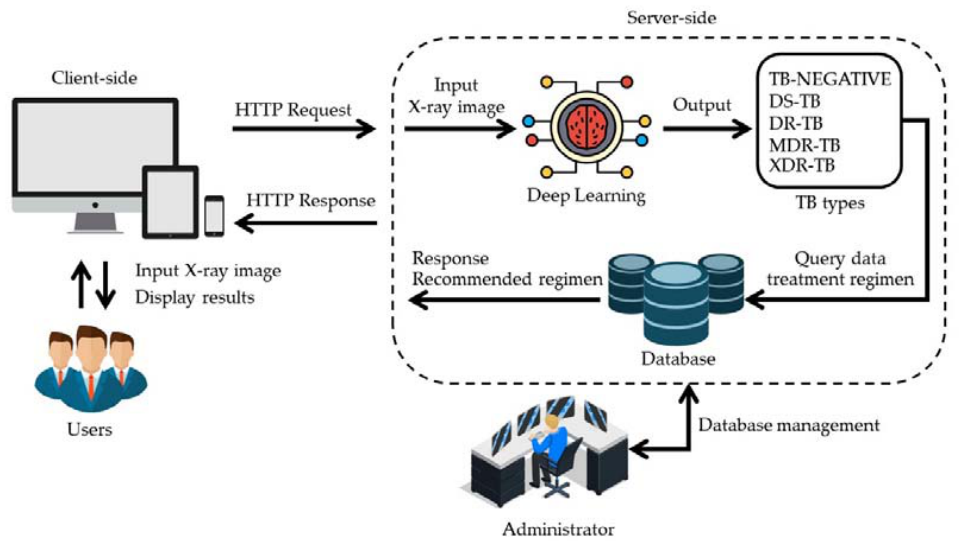
Figure 10. The design framework of web application for the case study (cid:5)